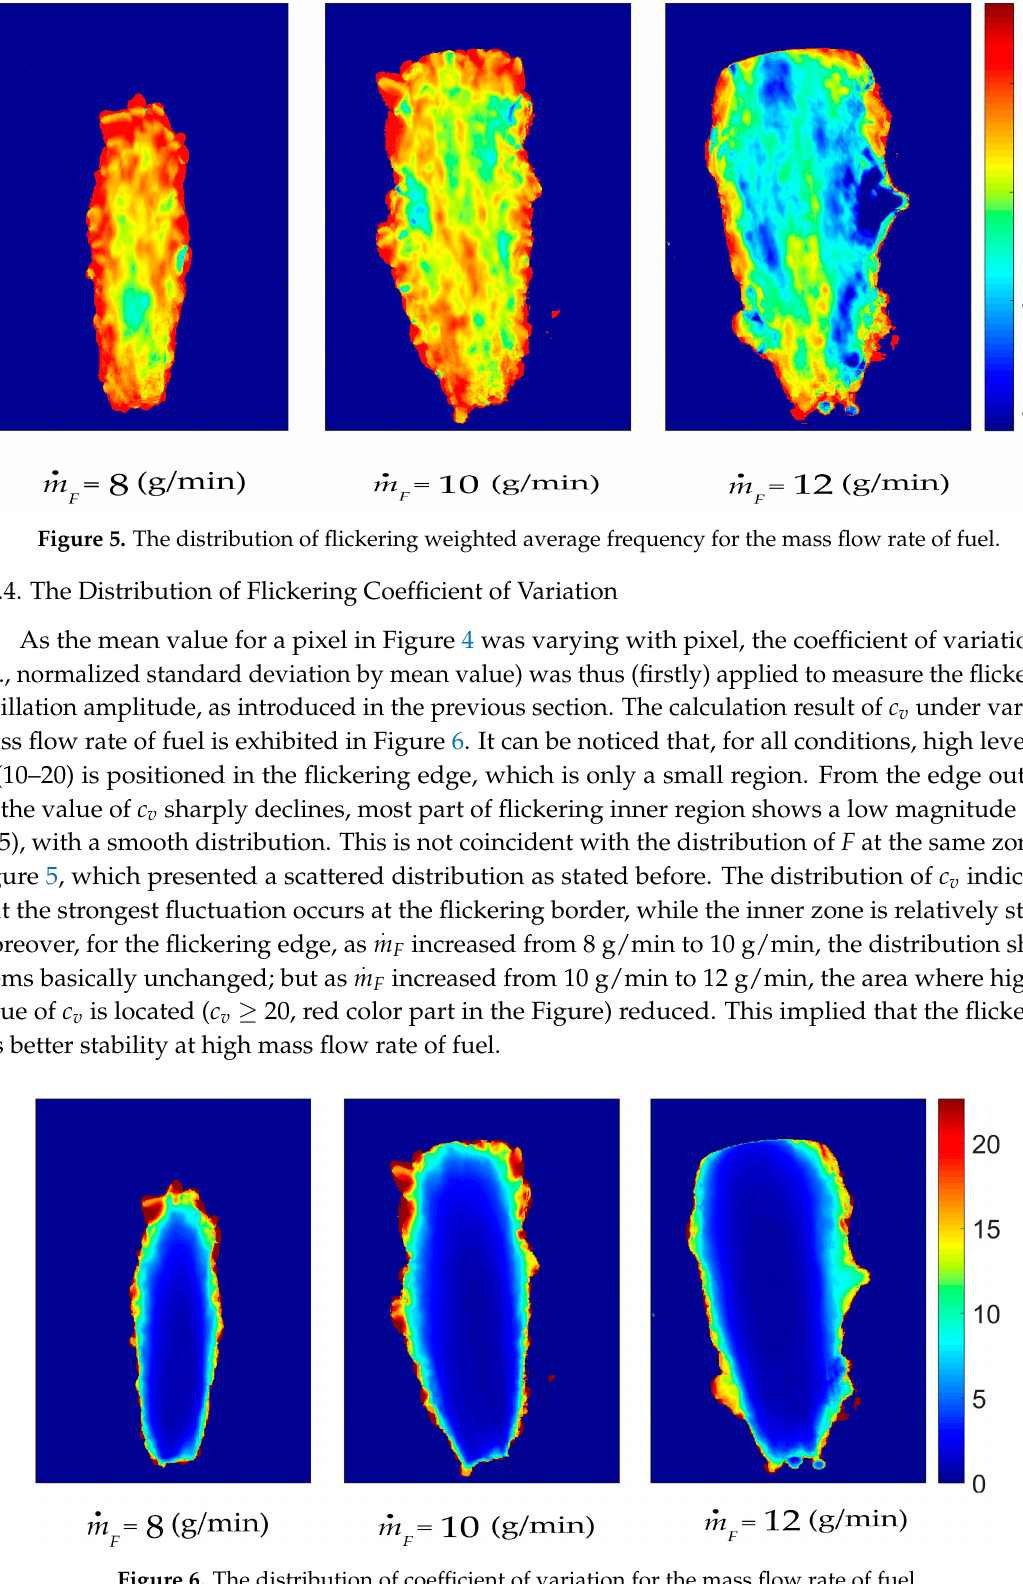
Figure 6. The distribution of coefficient of variation for the mass flow rate of fuel.